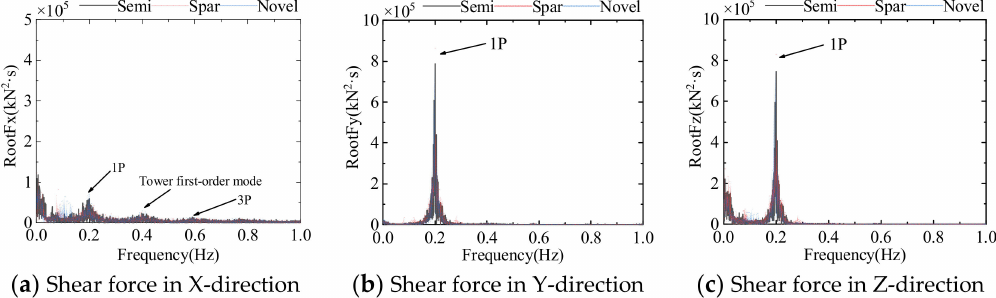
Figure 27. Power spectral density of blade root shear force of three FOWTs.